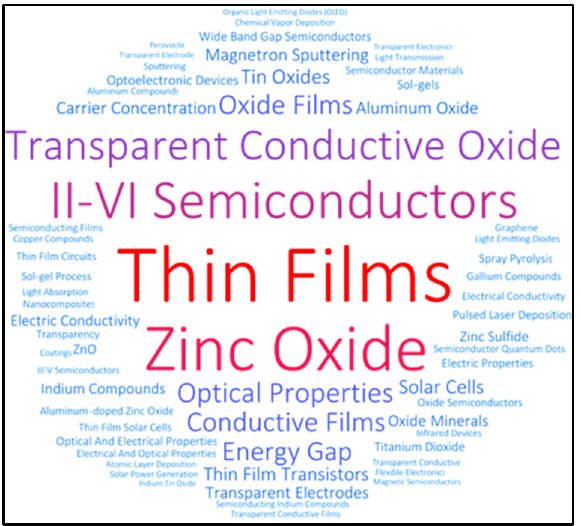
Figure 1. Main keywords of the bibliographic research on the topic “transparent semiconductor films” [4].